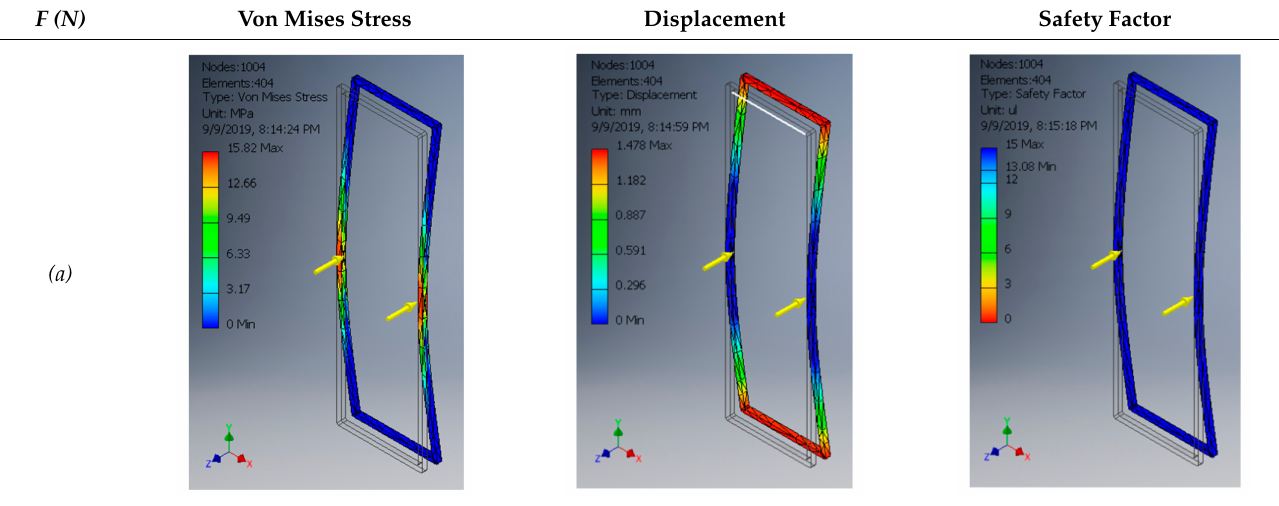
Figure 6. Overview of the force applied on the frame. Table 9. Von Mises stress, displacement and safety factor for the frame when applying loads of (a) 536.61 N, (b) 598.41 N, (c) 622.94 N and (d) 697.49